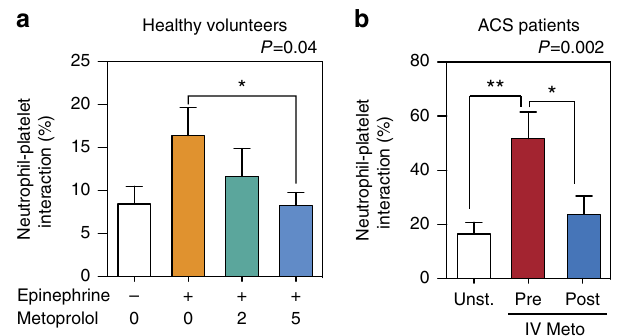
Figure 7 | Metoprolol inhibits neutrophil–platelet interactions in patients. ( a ) Effect of metoprolol on neutrophil–platelet co-aggregate formation in epinephrine-stimulated whole blood from healthy volunteers ( n ¼ 20). Whole blood was incubated in vitro with epinephrine 5 m M and metroprolol (Meto, concentrations in m M). ( b ) In vivo effect of metoprolol (up to15mg i.v.) on the number of neutrophil i.v.platelet co-aggregates in acute coronary syndrome (ACS) patients scheduled for coronary angio- plasty. Blood was drawn before and after metoprolol i.v. administration; n ¼ 6 ACS patients. Pre, before i.v. administration; Post, after i.v.